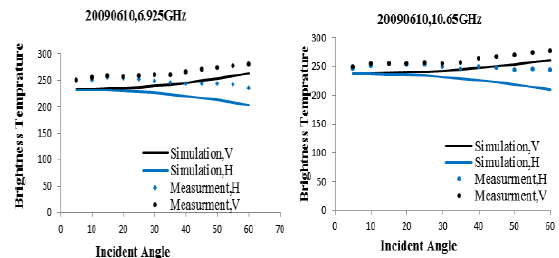
Figure 2, Comparison the TMMR measured and the matrix doubling model simulated brightness